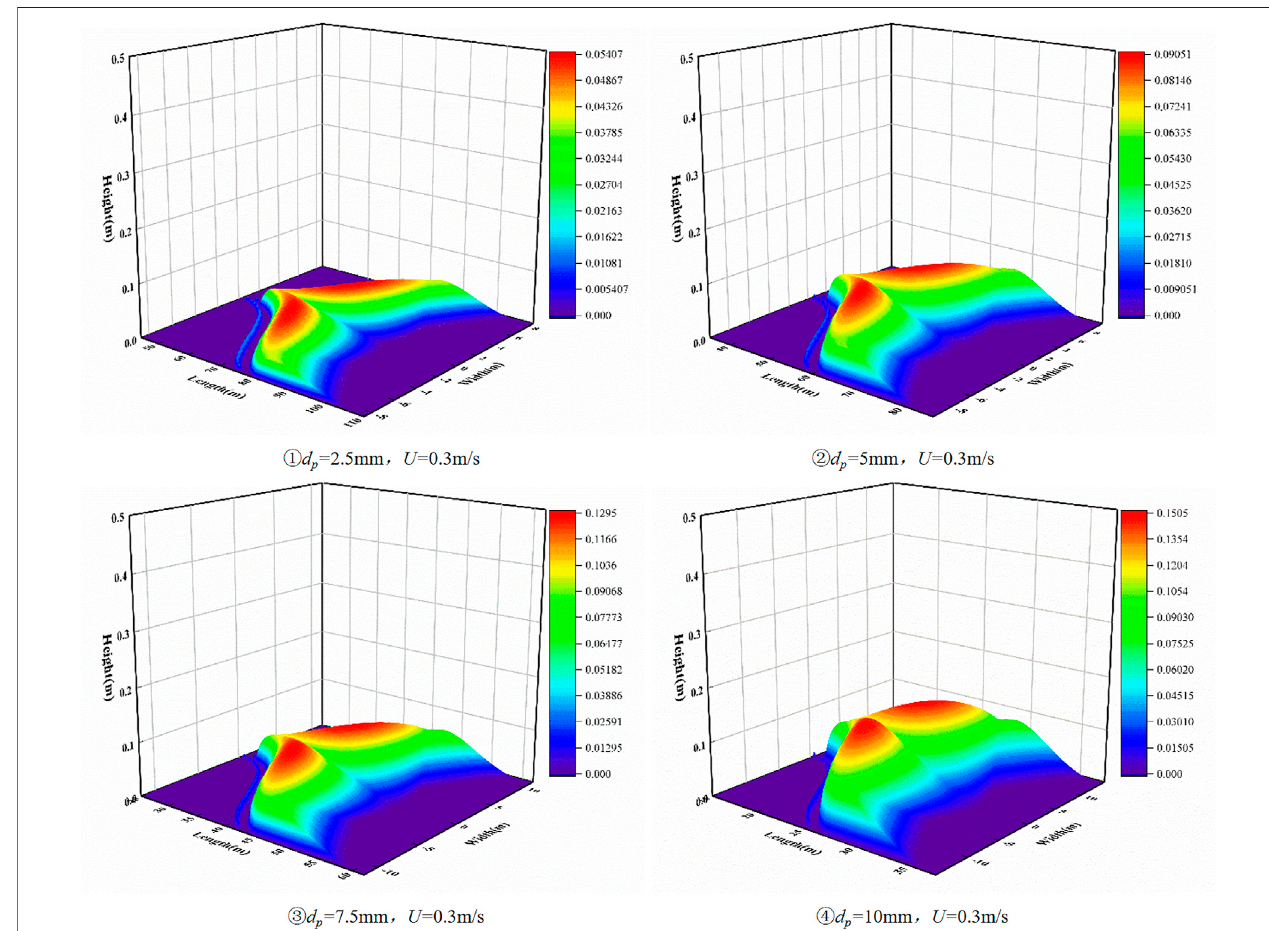
FIGURE 14 | Variation of sedimentary bed morphology distribution with particle size